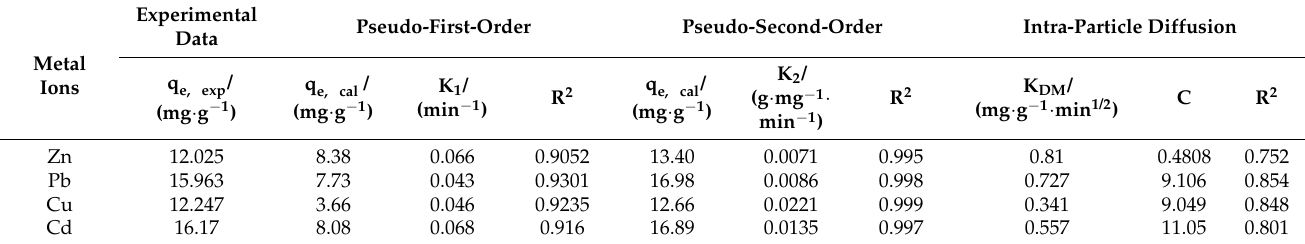
Table 3. A comparison for rate constants of pseudo-first-order, pseudo-second-order and intraparticle diffusion kinetic models calculated from experimental